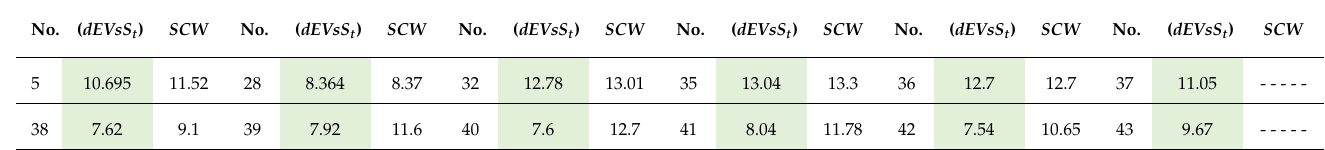
Table 9. Another verification for proposed methodology with Sine-cosine and Whale optimization scheduling in